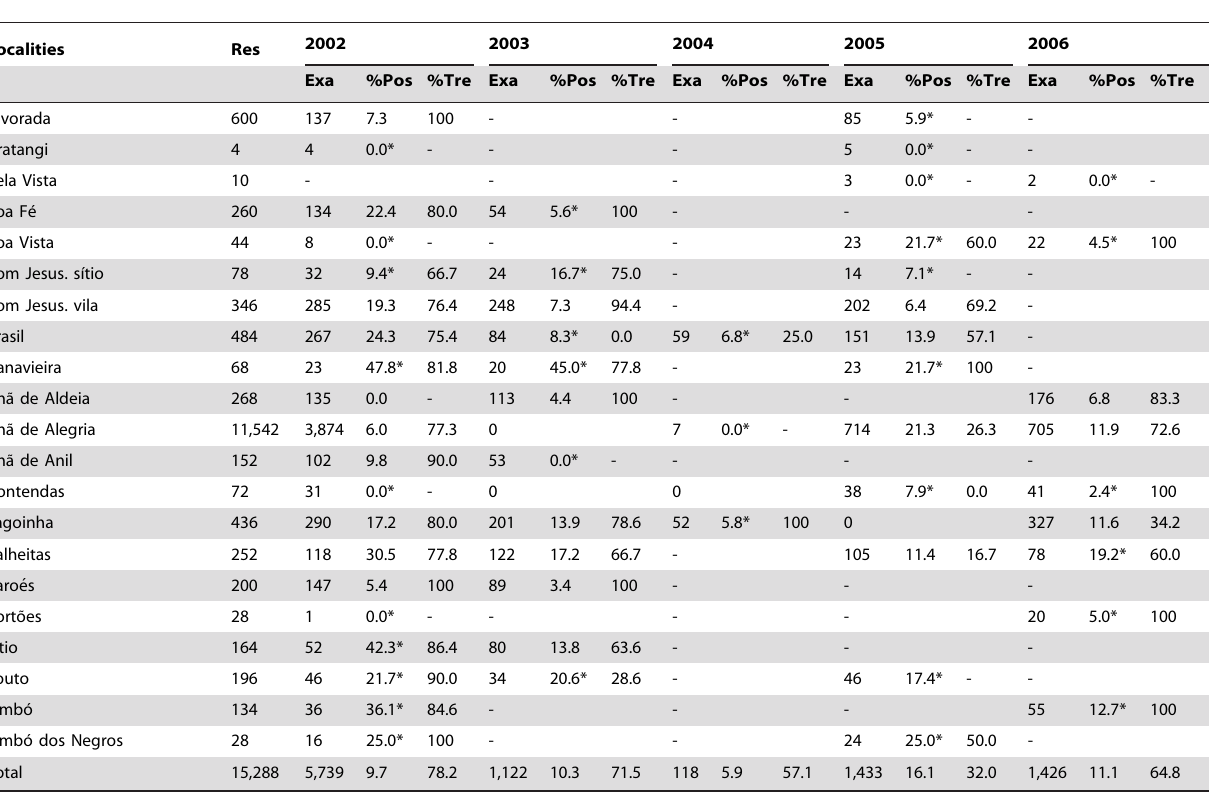
Table 2. Results from stool survey and treatment of the positives in the municipality of Cha˜ de Alegria as compiled yearly by the State Secretary of Health of Pernambuco and made available at the SISPCE